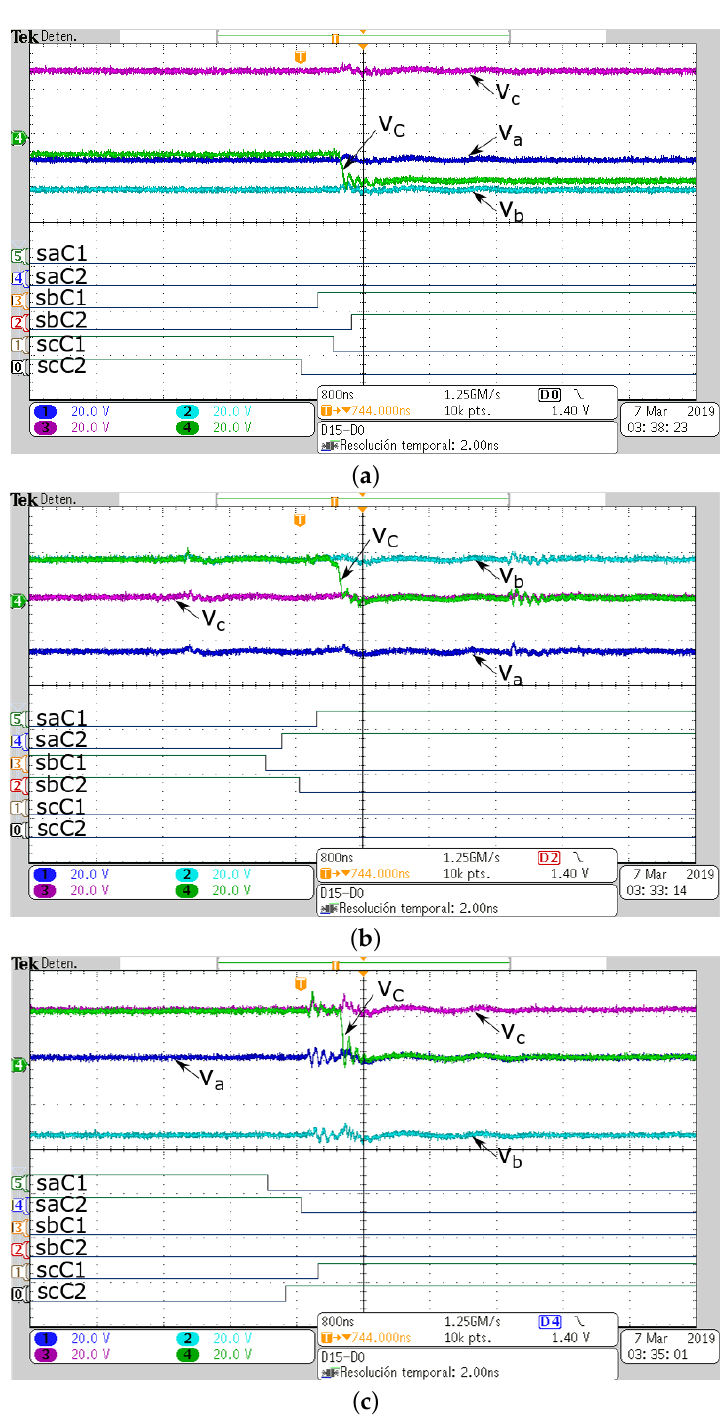
Figure 11. Output voltage transitions ( a ) v aC to v bC , ( b ) v bC to v cC , and ( c ) v bC to v cC